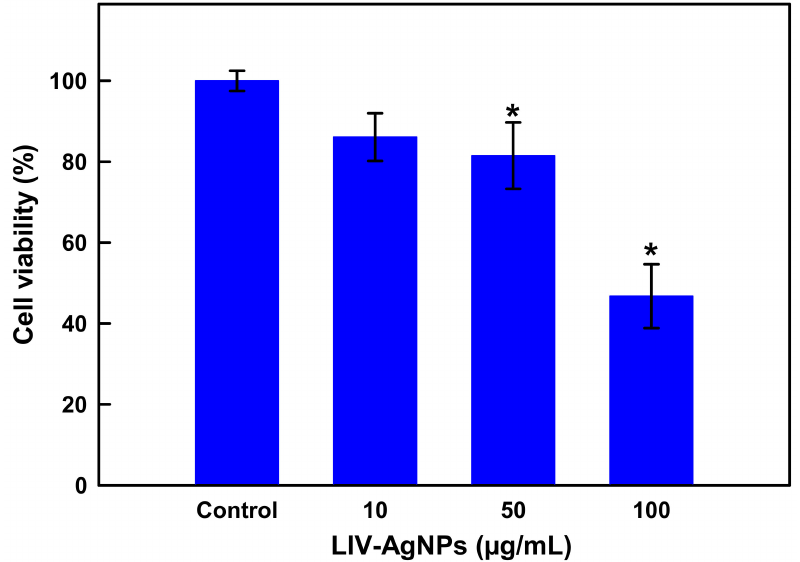
Figure 11. Dose-dependent cytotoxic effects of LIV-AgNPs against human colon cancer (HCT-116) cells quantitated by MTT assay after 24 h of incubation. Histograms are the mean ± S.D. of three independent experiments done in triplicate. * p < 0.05 verses untreated